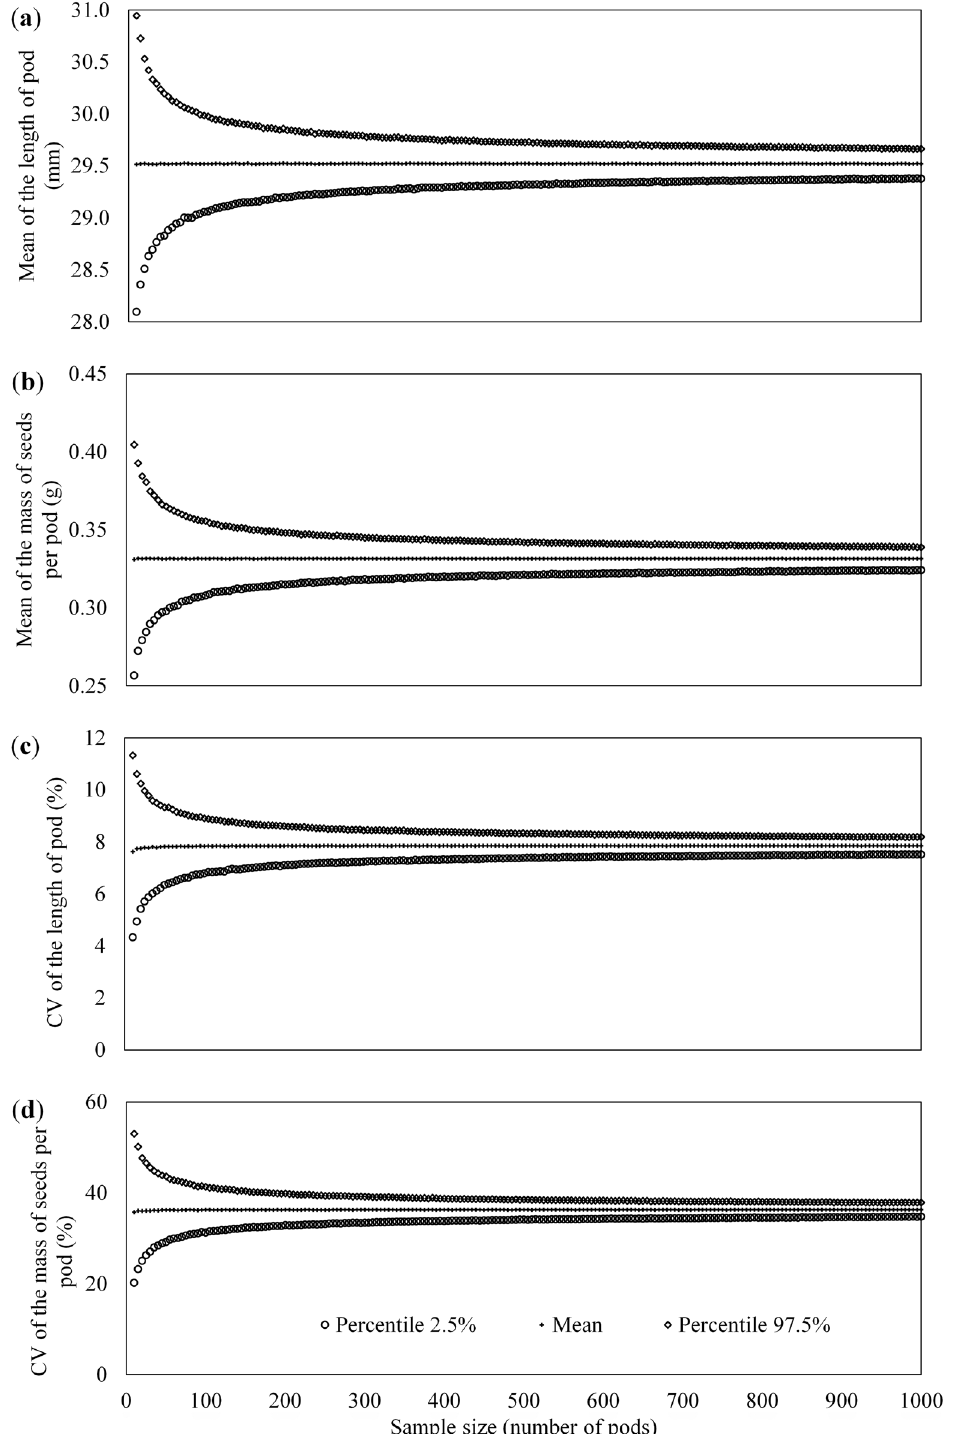
Figure 1 - Percentile 2.5%, mean and percentile 97.5% of 10,000 estimates of: ( a ) the mean of the length of pods, in mm; ( b ) mean of the mass of seeds per pod, in g; ( c ) the coefficient of variation (CV) of the length of pods, in %, and; ( d ) the coefficient of variation of the mass of seeds per pod, in %, for the sample sizes n = 10, 20, ..., 1,000 pods of Crotalaria juncea